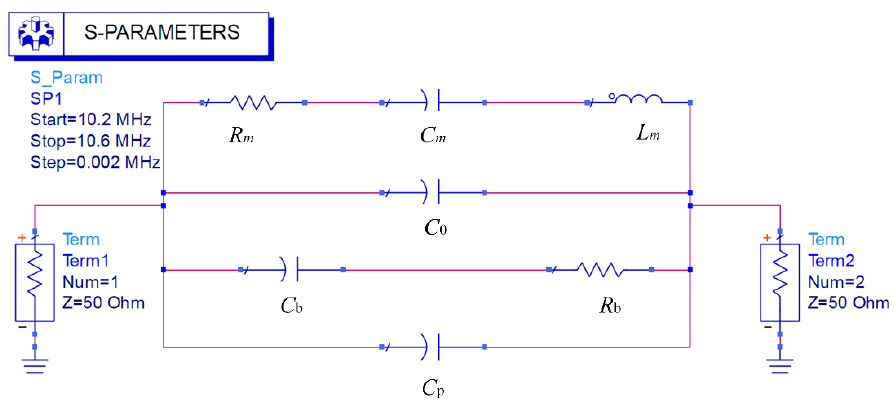
Figure 7. Equivalent circuit model of the resonator.